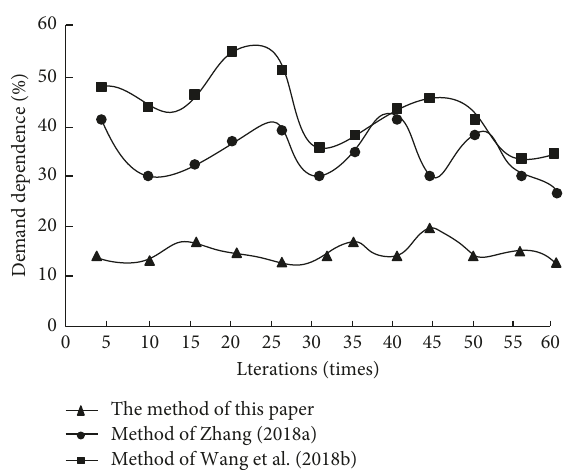
Figure 3: Requirement dependence under different